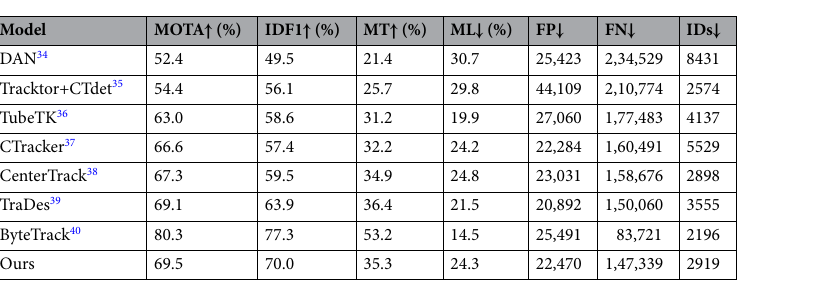
Table 4. Comparison of the proposed algorithm with existing methods.